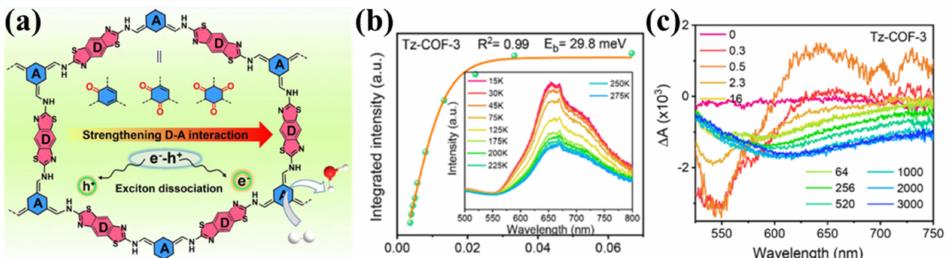
Figure 7. ( a ) Schematic illustration of the synthesis of Tz-COFs with adjustable D-A interactions toward photocatalysis. ( b ) Integrated PL intensity as a function of temperature of Tz-COF-3 (inset: temperature-dependent PL spectra from 15 to 273 K). ( c ) Femtosecond time-resolved transient absorption spectra (fs-TAS) (time unit: ps) of Tz-COF-3. Reproduced with permission from Ref. [23]. Copyright: American Chemical Society,